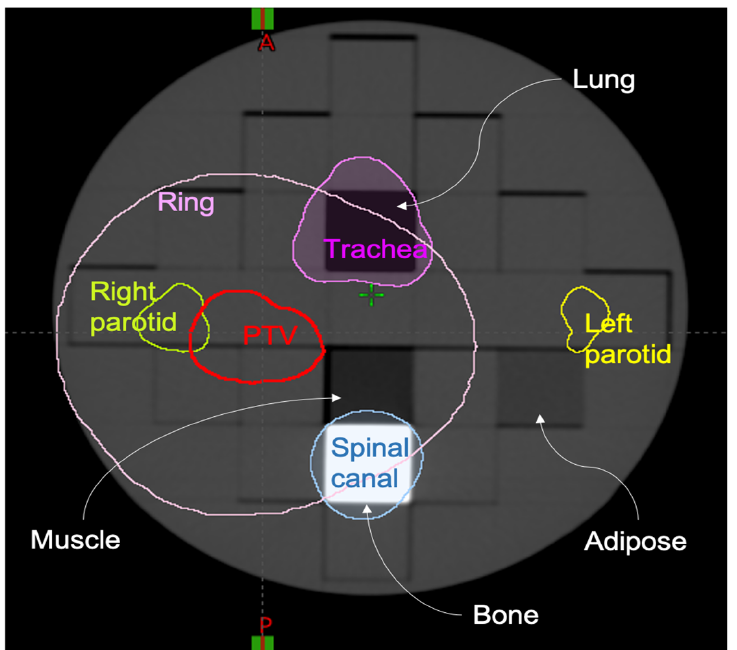
Figure 1. Planning CT of the phantom employed in the study and the countered Regions of Interest (ROIs). Six different ROIs were contoured: planning target volume (PTV), left parotid, right parotid, spinal canal, trachea and RING. Ring structure is the expansion of 3 cm from the PTV and cropped of 0.0 cm from the PTV edge.